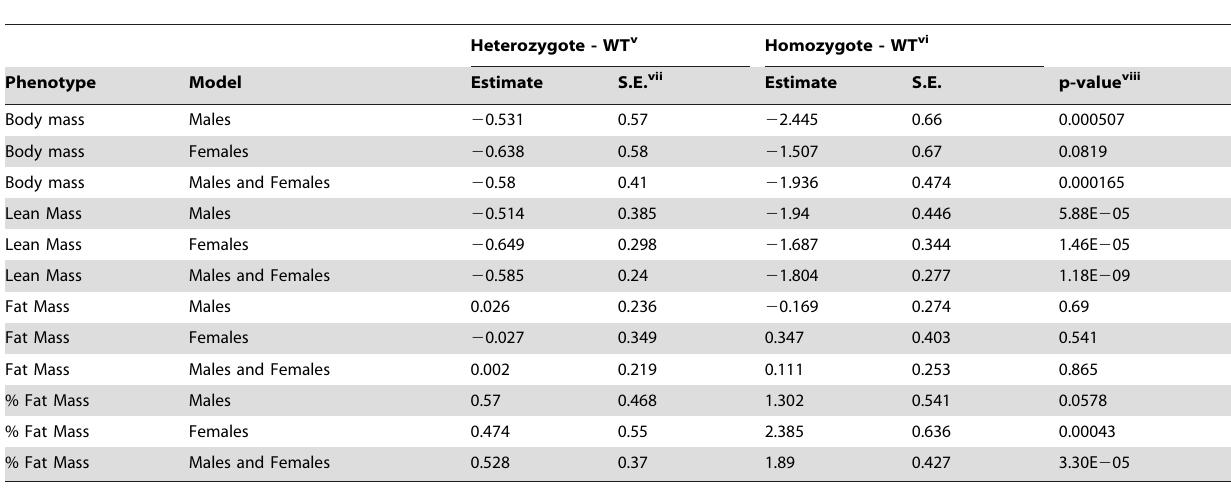
Table 2. Repeated measures ANOVA—results for Negr1 -I87N